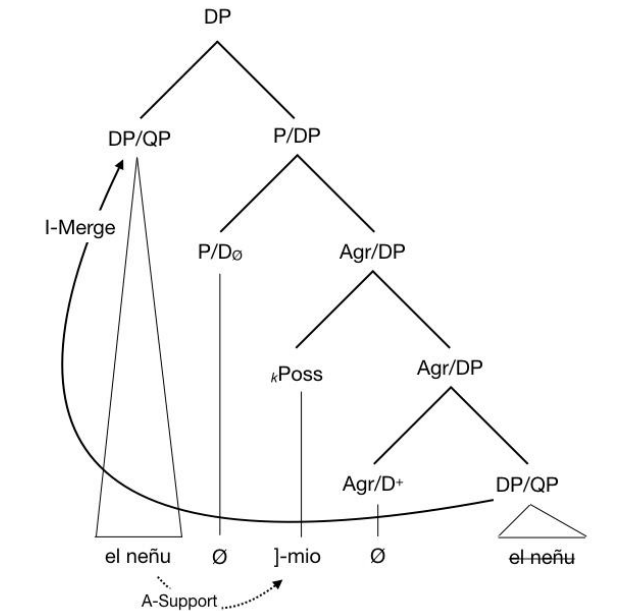
Figure 8. Postnominal possessive construction (Type II: e.g. el neñu mio